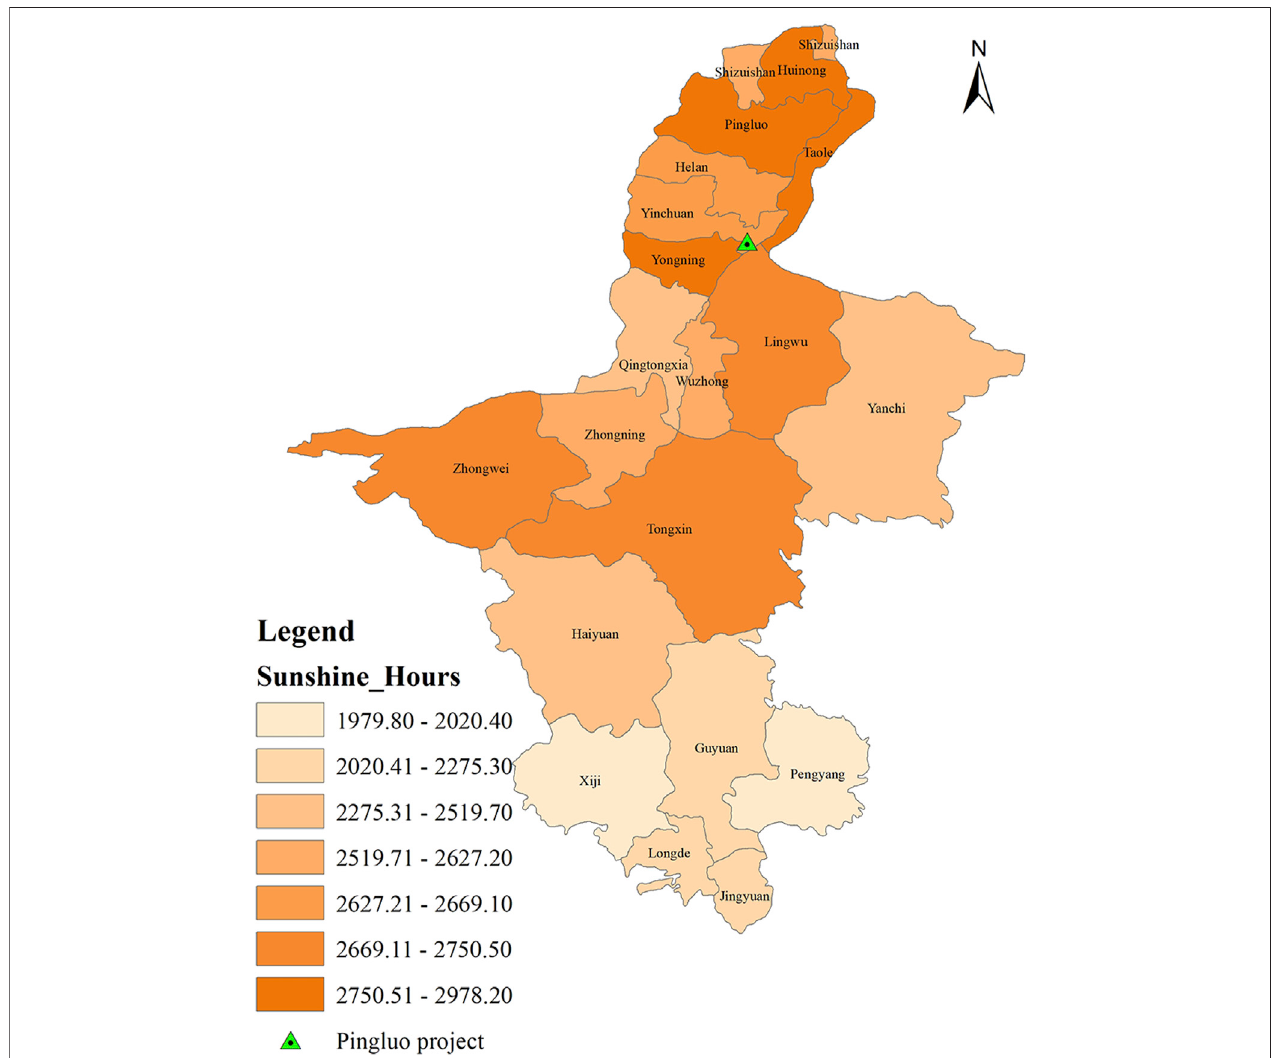
FIGURE 7 | Average annual sunshine duration in Ningxia